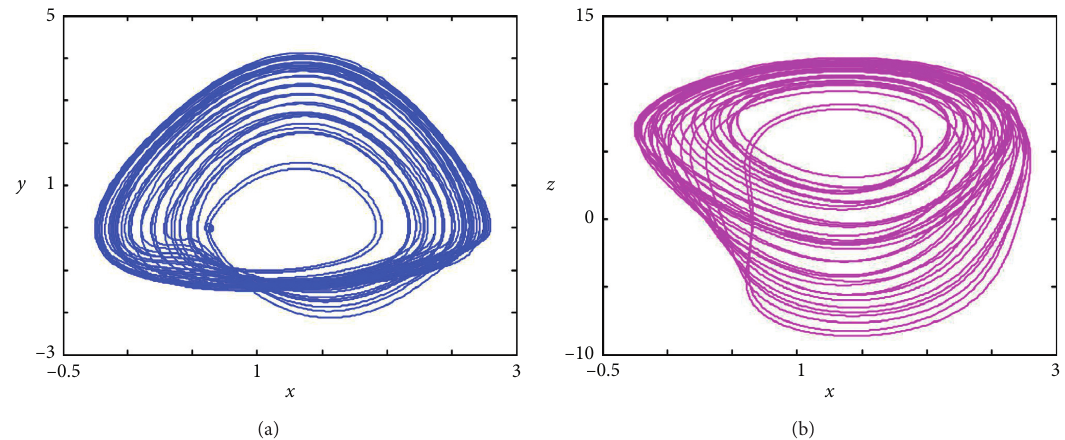
Figure 10: Phase diagrams of the fractional-order centrifugal flywheel governor system with initial values [1, − 2, 2,